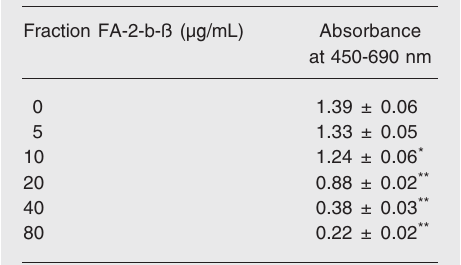
Table 3. Change in telomerase activity of HL-60 cells treated with various doses of fraction FA-2- b-ß for 96